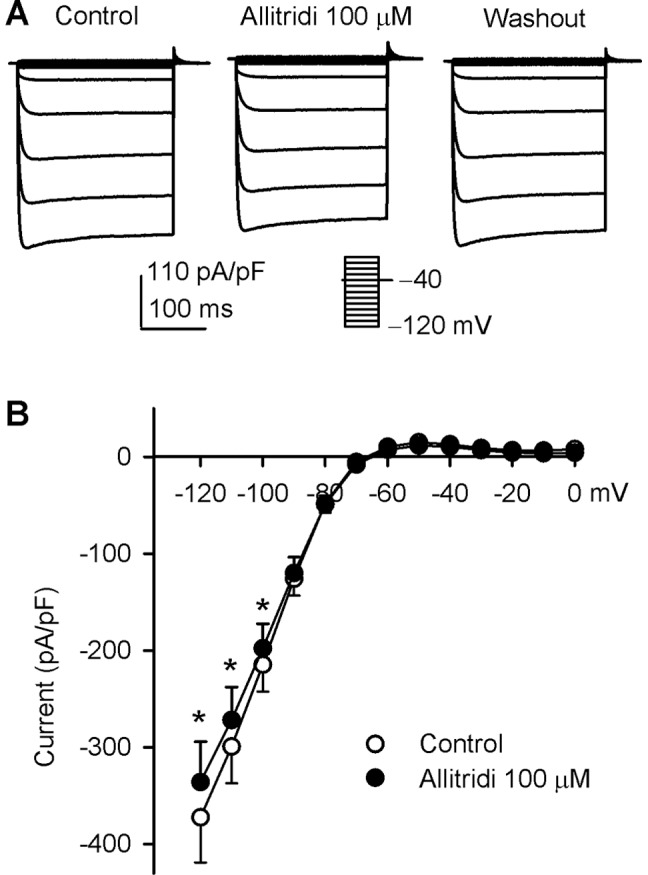
Effect of allitridi on hKir2.1 current.
A. Voltage-dependent hKir2.1 current recorded in a representative cell with the voltage protocol as shown in the inset, in the absence and presence of 100 µM allitridi. C. Current-voltage (I-V) relationships of hKir2.1 current before (control) and after application of 100 µM allitridi (n = 6, *P<0.05 vs. control).